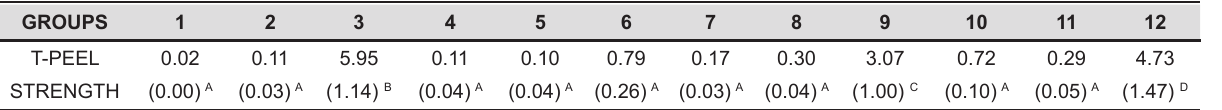
Bond strength between acrylic resin and maxillofacial Table 3- T-peel strength mean values (N/mm) and (standard deviation) for all groups